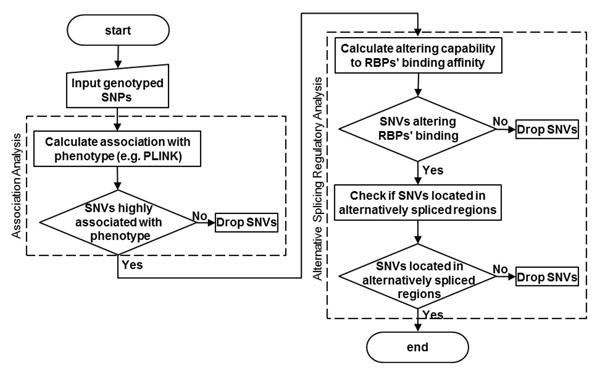
Proposed workflow